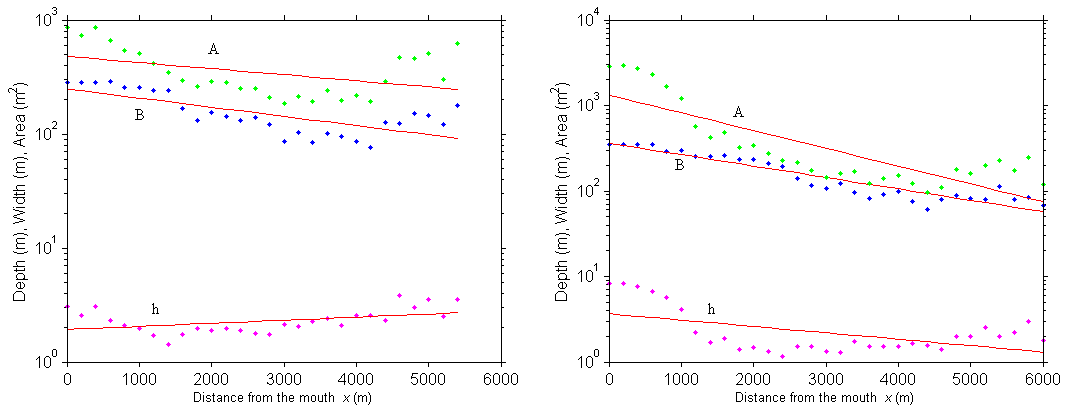
Figure 10. Geometry of the eastern branch (left) and western branch (right); showing the longitudinal variation of the cross-sectional area (A), the width (B), and the depth (h).